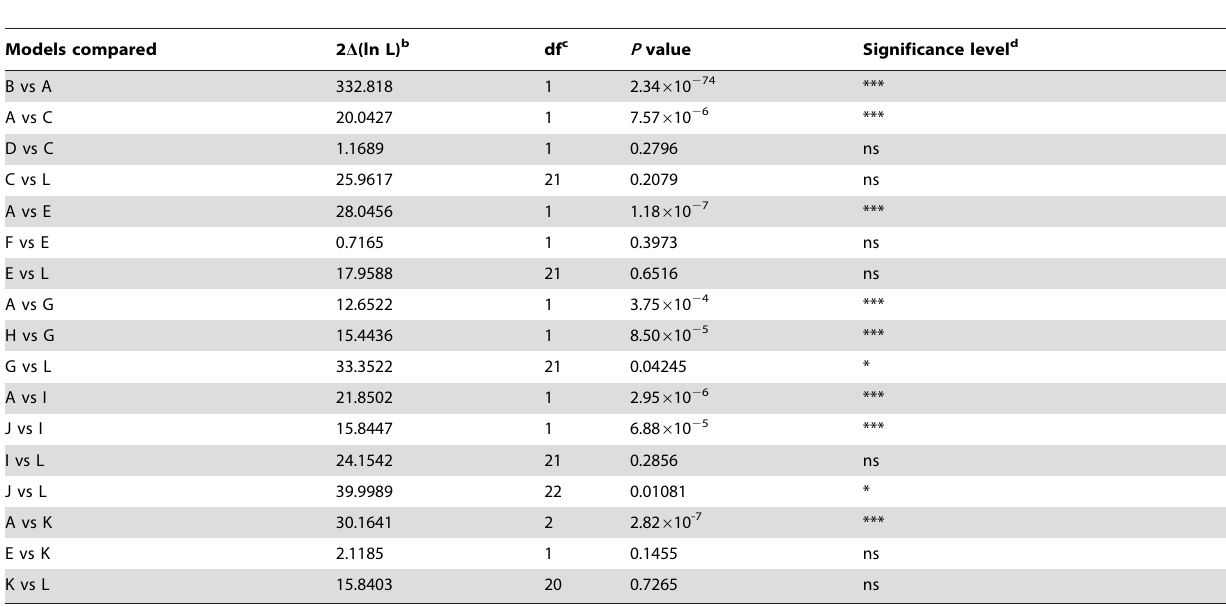
Table 3. Likelihood ratio tests of selective pressure on catarrhine MOXD2 gene a .